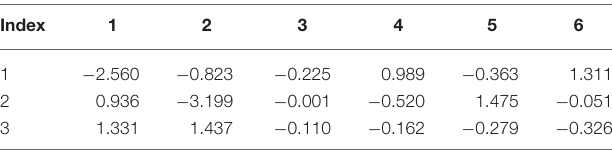
TABLE 6 | Internal strain tensor (Voigt notation) of Br 1 for displacements in x, y, z (eV/Å).